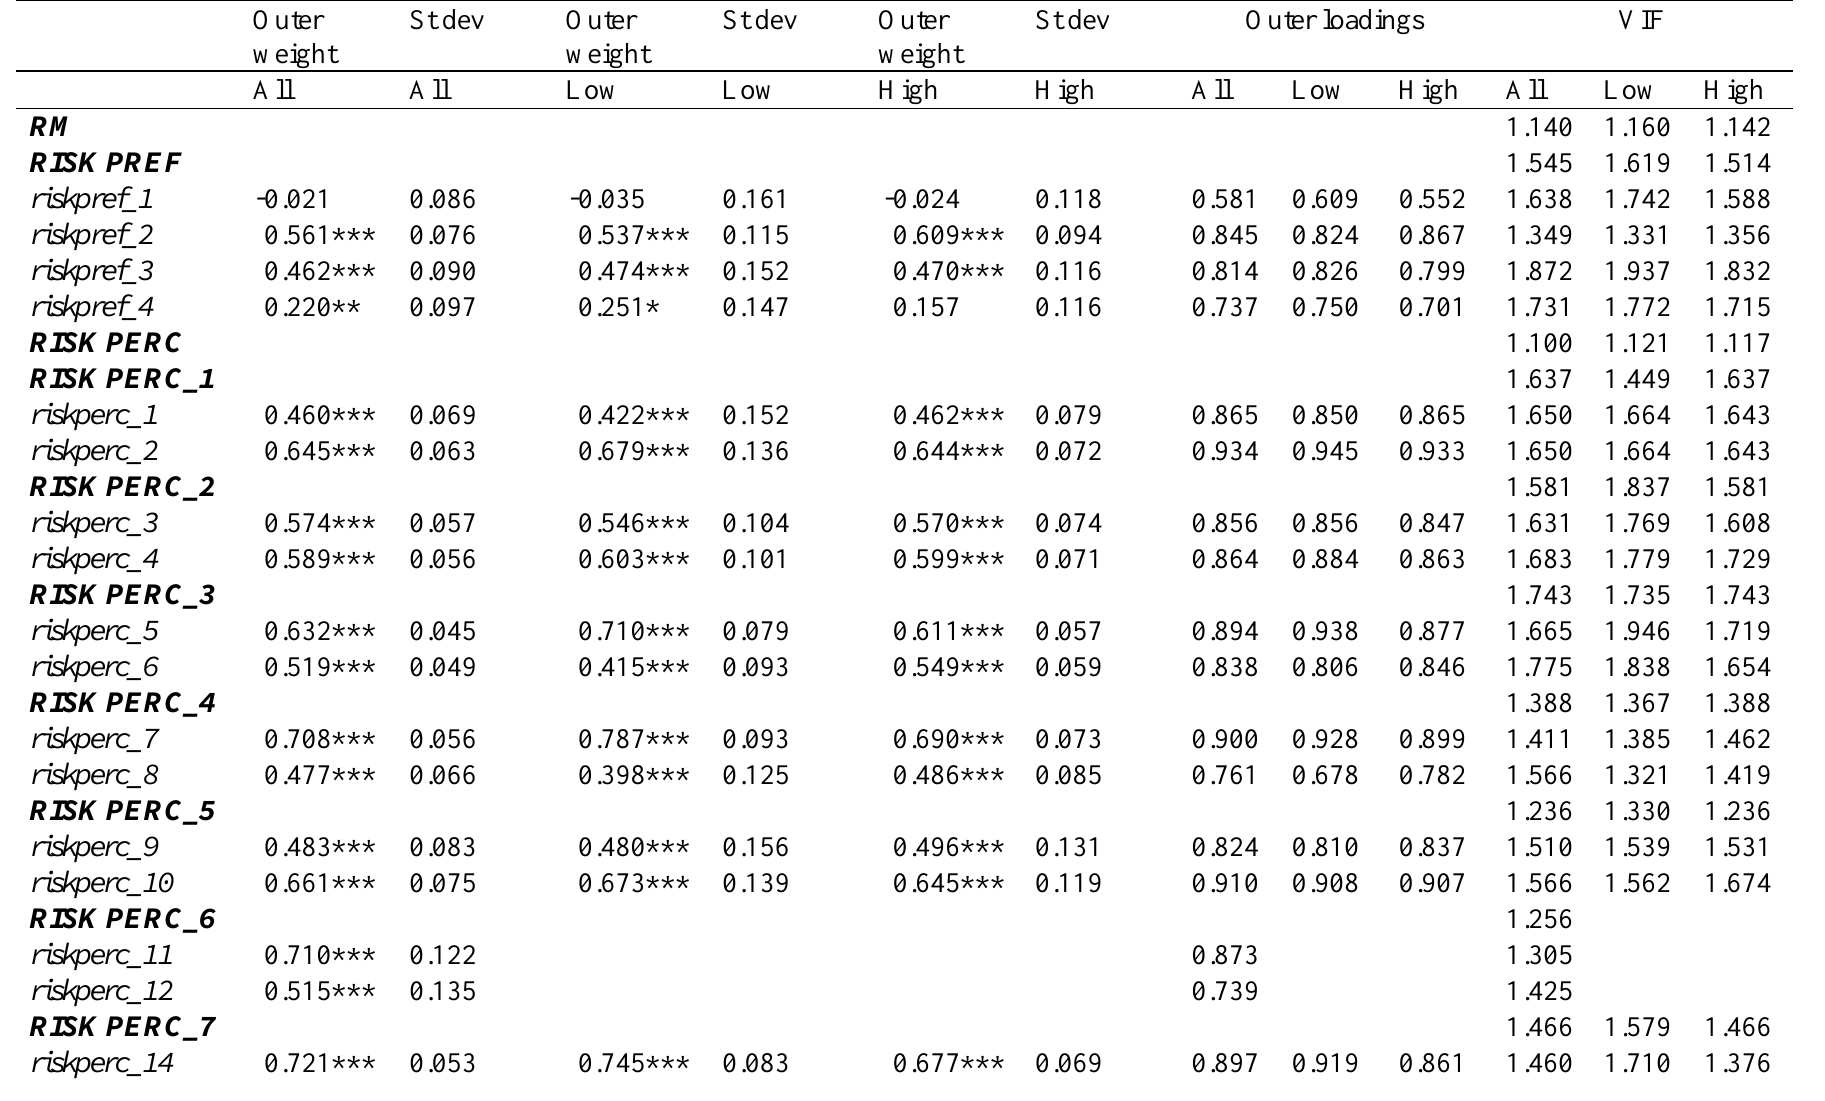
Table A1.4 Formative item validity assessment (reduced